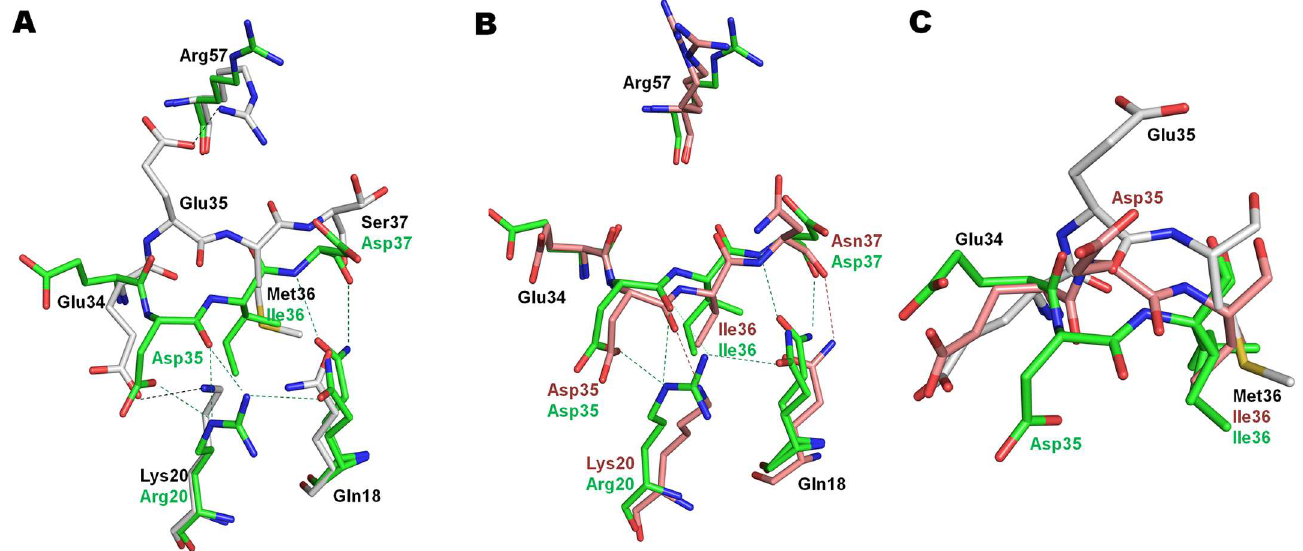
Fig 3. Conformational Changes in Hinge Loop Mutations E35D, M36I and S37N. A. Conformational changesin the hinge loop of PR S17 /DRV complex in comparisonto PR/DRV. B. Comparisonof hinge loop betweenPR S17 /DRV and PR20/DRV. C. Hingeloop conformation of PR S17 /DRV, PR/ DRV and PR20/DRVin subunit B. Wild-type PR, PR S17 and PR20 carbons are shown in grey, green and salmon,